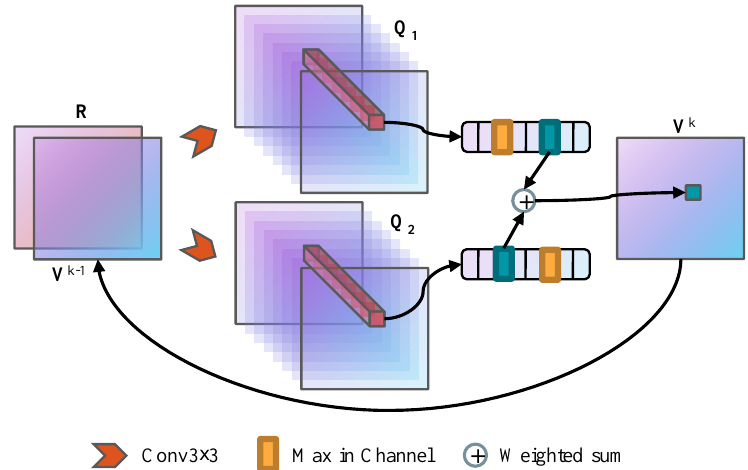
Figure 3. The approximate VI module with weighted double